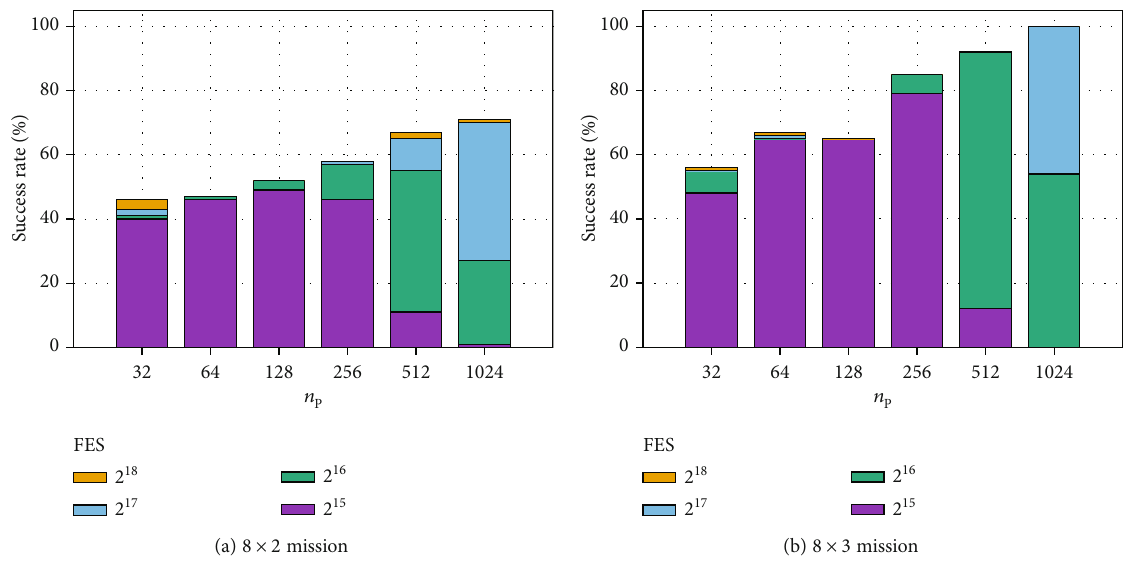
Figure 9: GA success rate as a function of the population size n